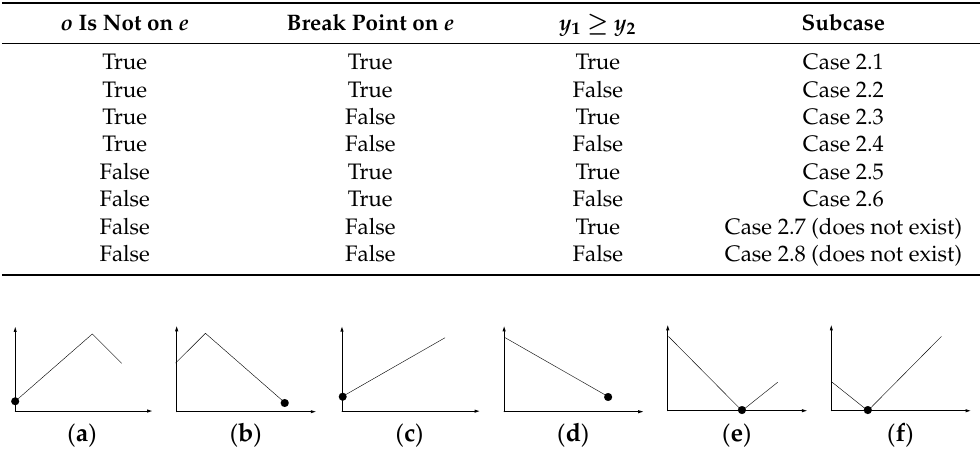
( d ) Figure A2. dist ( o , p )× CI ( Q , p ) graphs for Case 1: ( a ) case 1.1, ( b ) case 1.2, ( c ) case 1.3, and ( d ) case 1.4. In Cases 1.1–1.4, lowDist ( G i , p ) is a non-negative number less than or equal to the distance from p to any given vertex in G i ; thus, lowDist ( G i , p ) ≤ y l , y r , which means that lowDist ( G i , p ) ≤ dist ( o , p ). Because CI ( Q , p ) ≥ 0, CI ( Q , p ) × lowDist ( G i , p ) = LB ( G i , p ) ≤ CI ( Q , p ) × dist ( o , p ). Case 2. CI (Q, p ) ≥ 0 and p belongs to G i . This case can be divided into eight subcases depending on three conditions. Again, we let dist ( o , e . l ) be y l and dist ( o , e . r ) be y r . As shown in Table A7, the three conditions are as follows: (1) Is o on e ? (2) Are there any Break points on e ? (3) Is y l less than or equal to y r ?